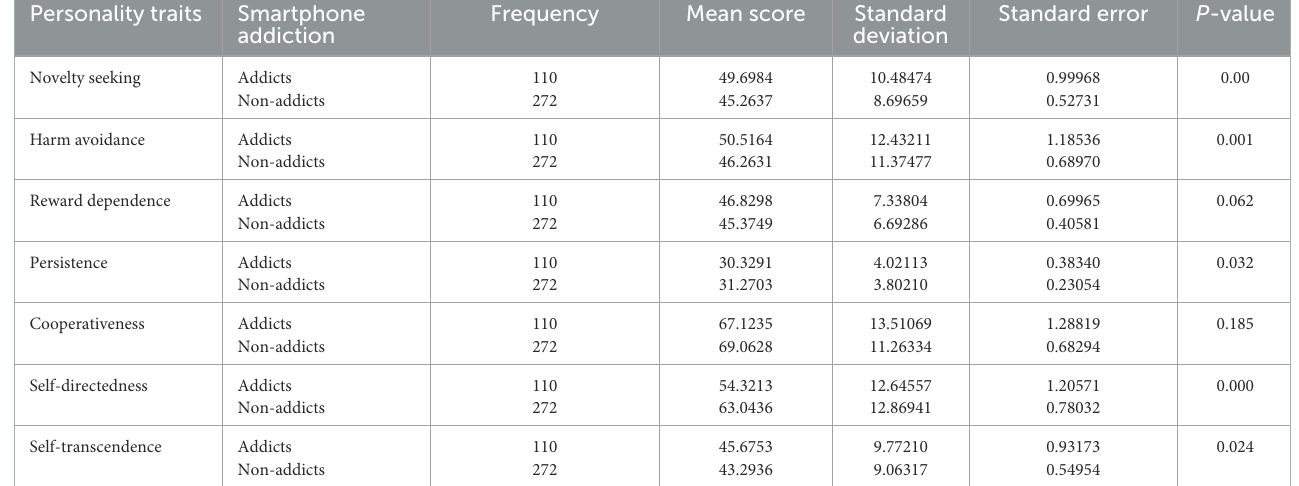
TABLE 3 Comparison of personality traits based on smartphone addiction in Tehran’s university students. Personality